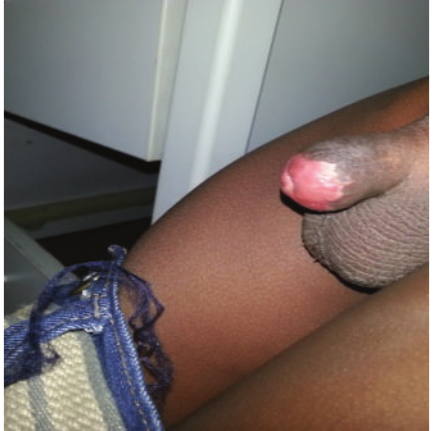
Figure 8: Glans penis at six months (lateral view).